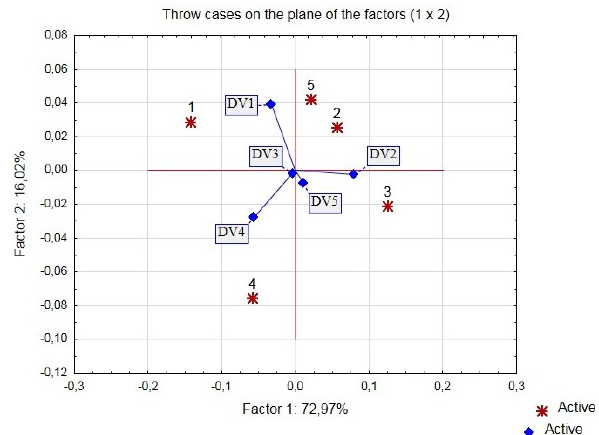
Figure 8: Common coordinate diagram of criteria factors and tech- nology and material